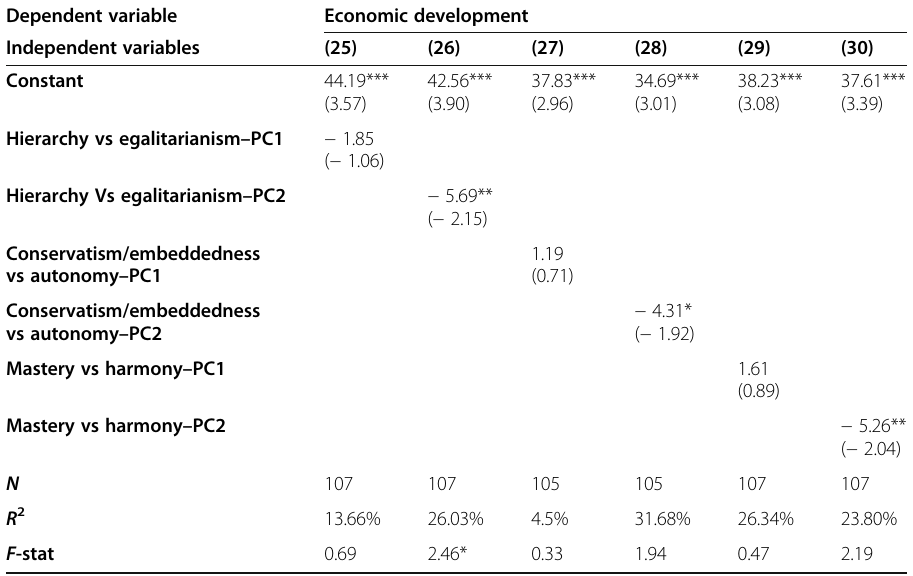
Table 14 The effect of culture on economic